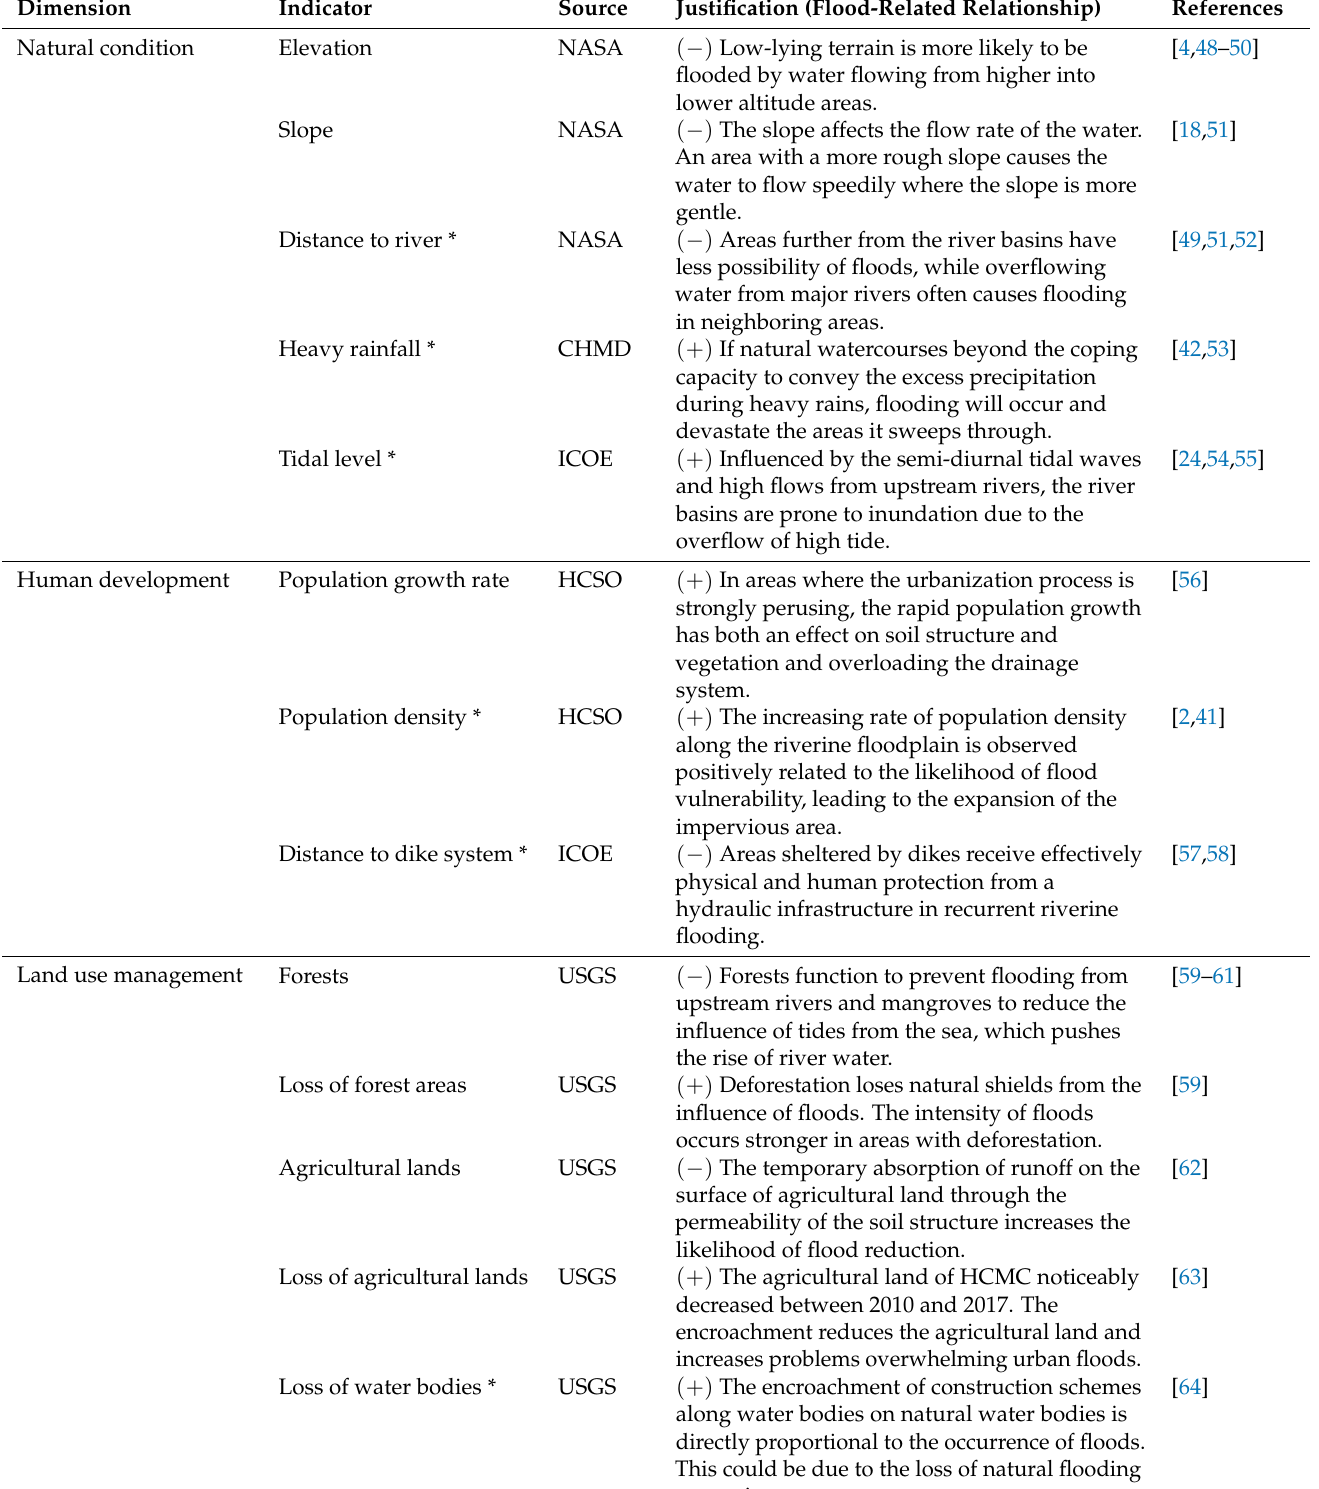
Table 1. The list of flood hazard and vulnerability indicators identified for